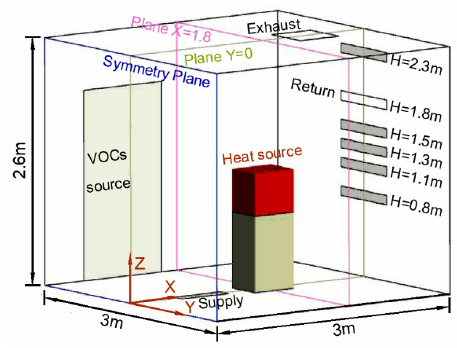
Figure 2. Schematic illustration of the model room. Table 1. Boundary conditions of simulation.